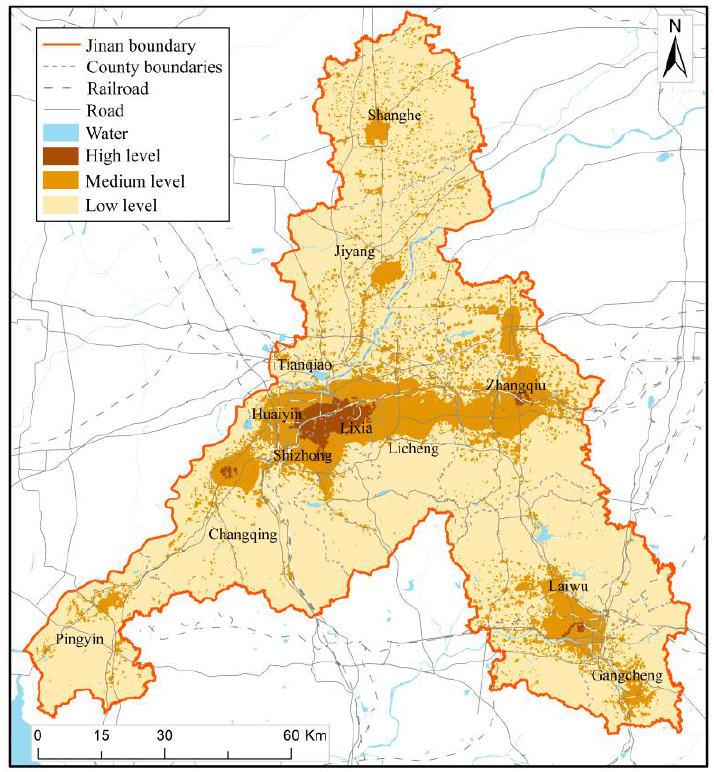
Figure 4. Result map of exposure assessment.